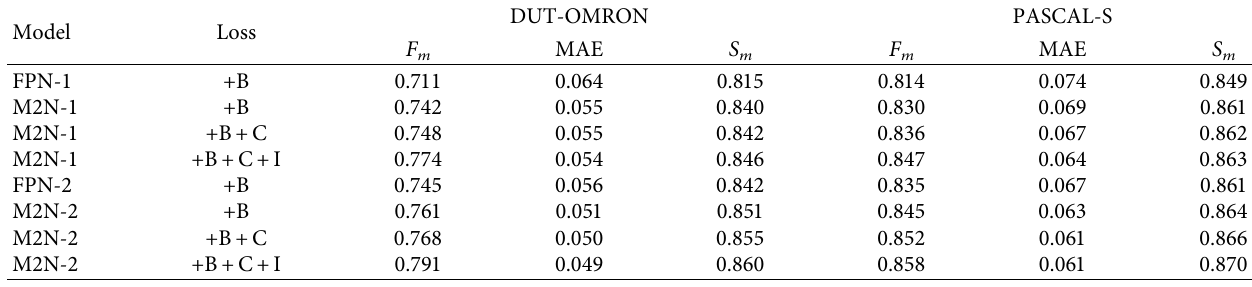
Table 4: Ablation analysis on two challenge datasets. FPN-1: FPN [48] with ResNet-50 backbone; FPN-2: FPN [48] with ResNeXt-101 backbone; M2N-1: the proposed M2Net with ResNet-based backbone; M2N-2: the proposed M2Net with ResNeXt-based backbone B: binary cross entropy; C: centerness; I: Intersection over Union.